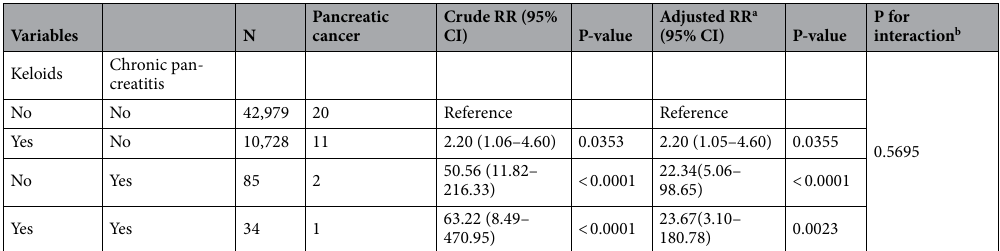
Table 6. Interacting effects of keloids and chronic pancreatitis on the development of pancreatic cancer in female patients with keloids. RR relative risk, CI confidence interval. a Model adjusted for age group, gender, and the residential region, liver cirrhosis and diabetes mellitus using a Cox proportional-hazards regression model. b Interactions between keloid cases and chronic pancreatitis were calculated using the Cox proportional hazards regression model with an added interaction term for keloid cases by chronic pancreatitis and